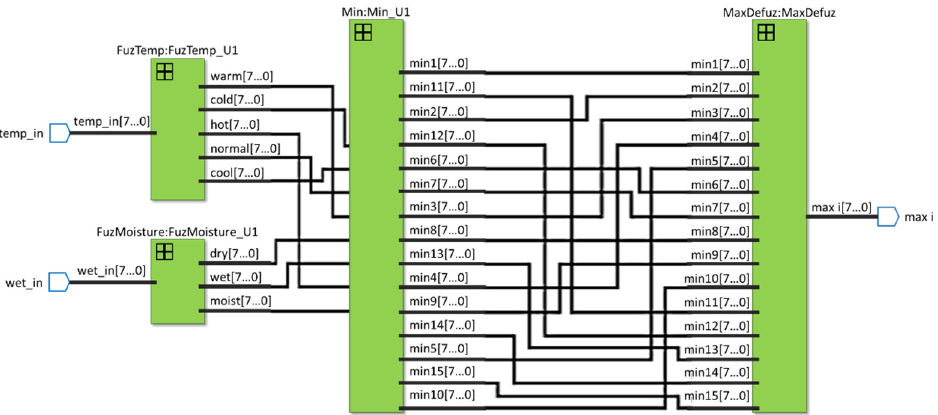
Figure 8. Modules of a fuzzy logic controller (FLC) embedded into a field-programmable gate array (FPGA) structure, considering four main modules with temperature (T) and relative humidity (RH) as inputs for the irrigation of rose cultivation.